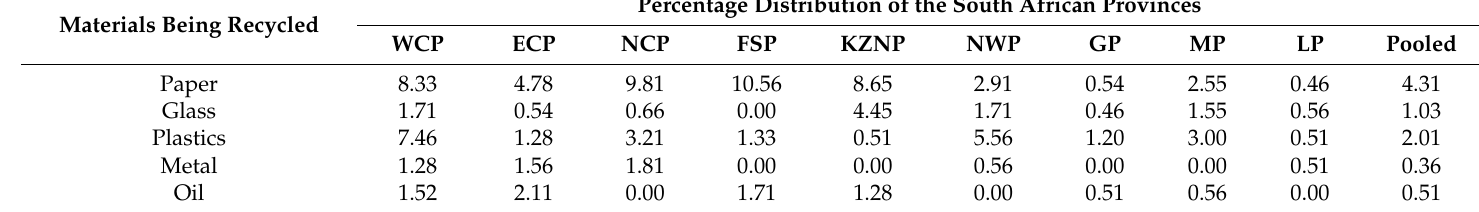
Table 5. Percentage distribution types of materials